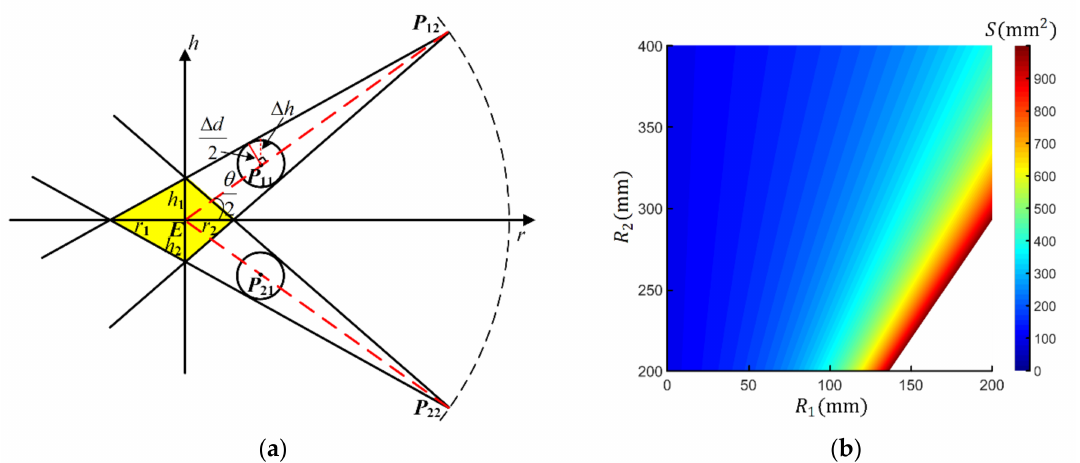
Figure 4. Error analysis of eyeball center estimation. ( a ) Error zone illustration. The distance between eyeball center and calibration tools are assumed as constant values. The r -axis refers to the line connecting E to the midpoint of P 12 P 22 . ( b ) The relationship between S and R 1 , R 2 when θ = 90 ◦ , ∆ d = 10 mm. Note that the white region in the heat maps means the error is larger than 1000 mm 2 , and we do not show the detail for better